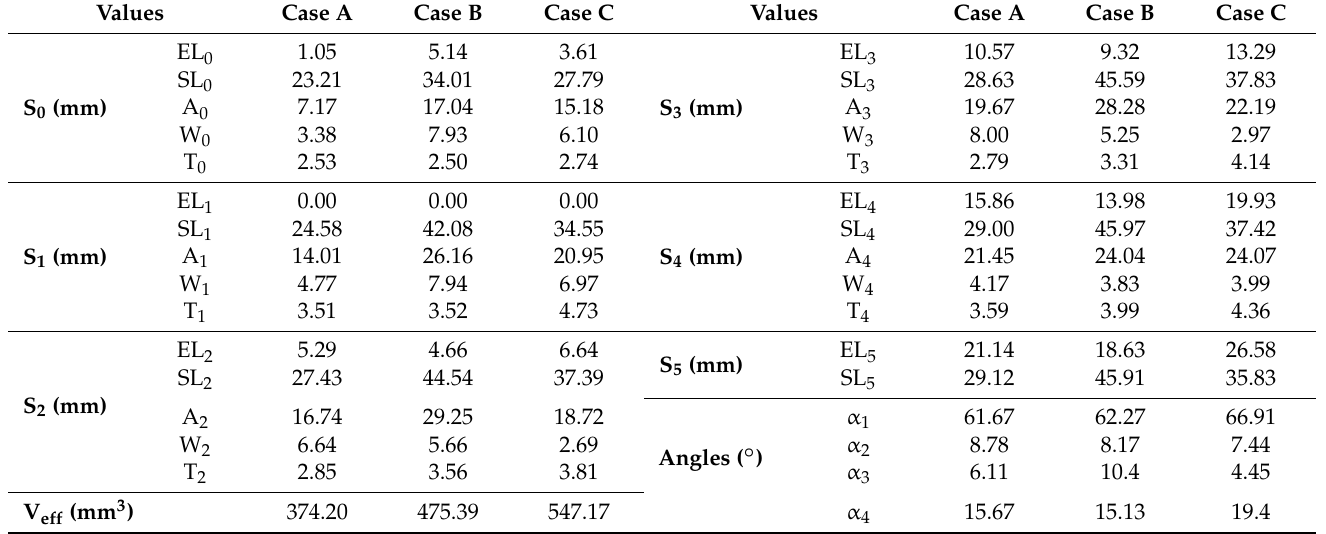
Table 3. Measured values in the proposed TPPs from three case scenarios. A total of 32 values